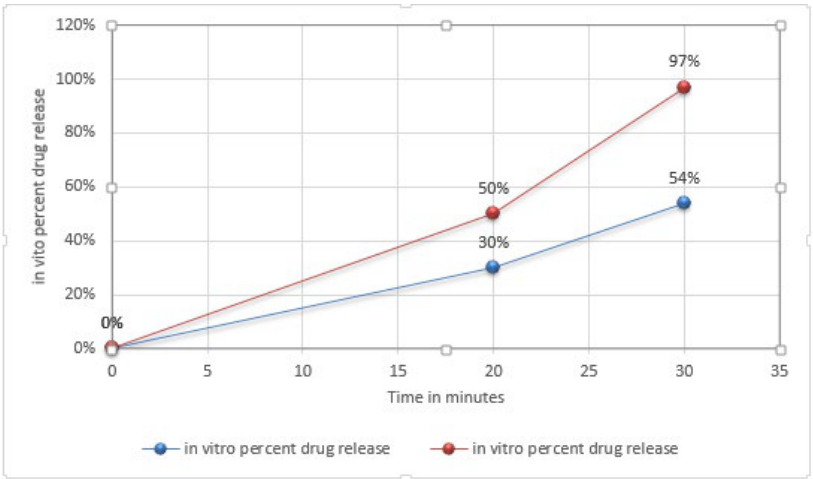
Figure 3. Comparison graph for direct compressed tablets and liquisolid compact. Red line represents percent drug release of conventional tablet, blue line represents percent drug release of liquisolid compact.